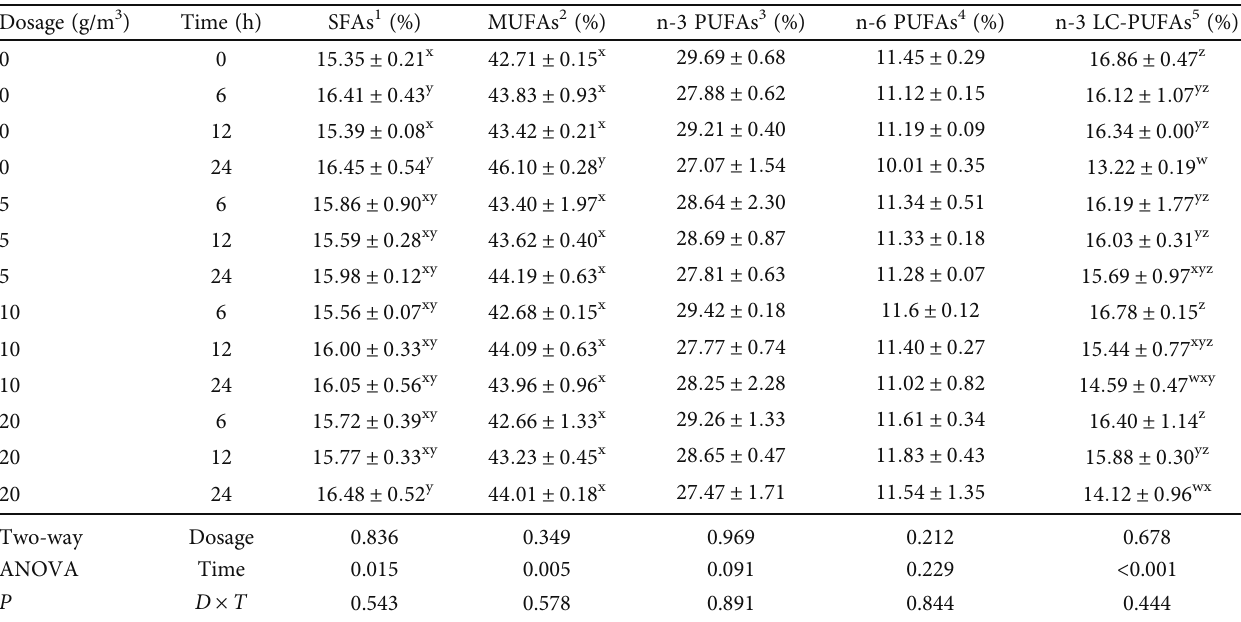
Superscript letters a, b, and c indicate the SL dosage e ff ect. Superscript letters x, y, and z represent the SL time e ff ect. Superscript letters A, B, and C represent the SL dosage and time interaction e ff ect. Values ( mean ± S : E : M : , n = 3 ) without superscript letters or sharing the same superscript within a column indicate no signi fi cant di ff erence ( P > 0 : 05 ). Table 2: Fatty acid composition analysis of Artemia nauplii